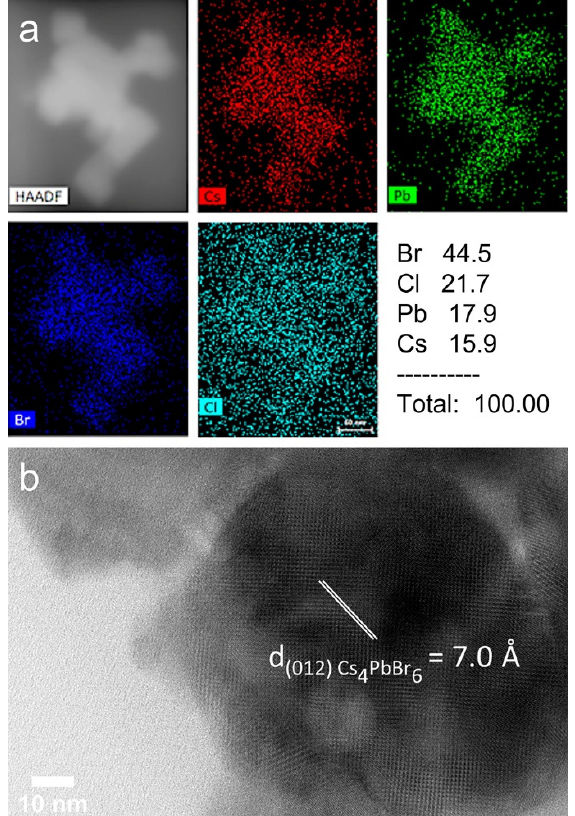
Figure 6. EDS mapping ( a ) and HRTEM images ( b ) of the nanohexagon DCB-based solution following irradiation with 1.8 × 10 6 pulses.